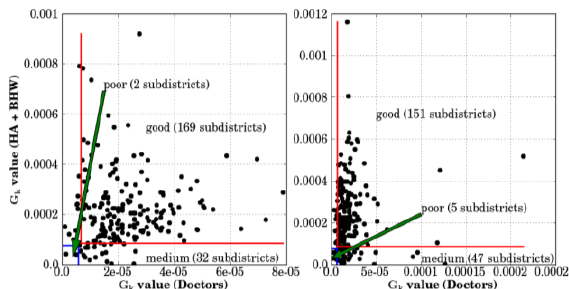
5 Doctors and Scenario 2 Option 2 for HA and BHW (Left), Scenario 2 Option 2 for doctors and Scenario 1 Treble method for HA and BHW (Right)